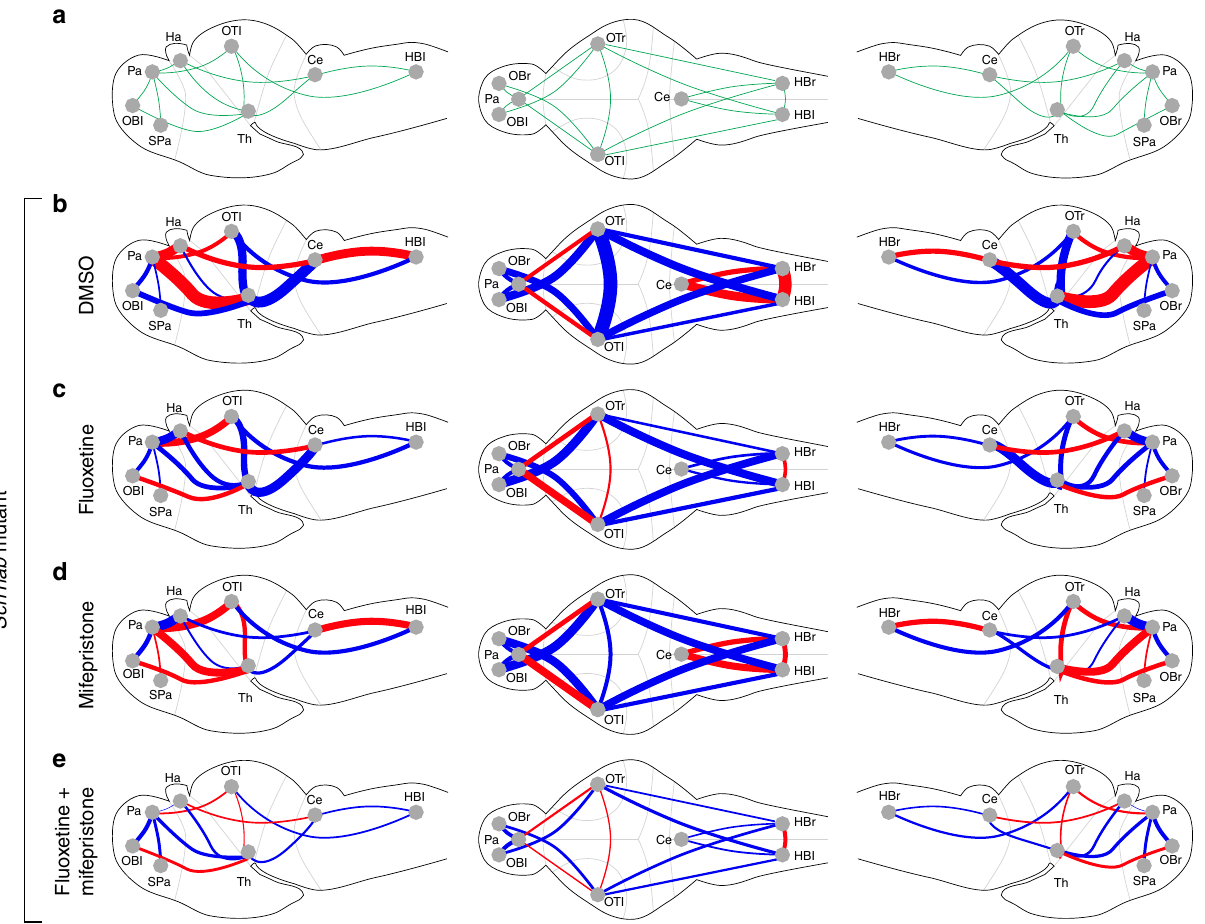
Fig. 4 Network-engineered polytherapy restores resting state brain connectivity in mutants. a Diagram depicting brain areas with statistically signi fi cant absolute correlation values (unpaired two-tailed Student's t -test; p < 0.05 considered signi fi cant; normality of datasets was tested using the Jarque – Bera normality test) in wild-type larvae at 5 dpf ( n = 10). Only these connections are shown in b – e . b – e Diagrams illustrating alterations in functional brain connectivity in scn1lab mutant larvae with respect to wild-type sibling controls under the following conditions: b untreated mutants (DMSO), c mutants treated with fl uoxetine alone at the 100% dose, d mutants treated with mifepristone alone at the 100% dose, and e mutants treated simultaneously with fl uoxetine and mifepristone using one of the optimal polytherapy dose regimens (both drugs at 30%). For all diagrams, brains are shown from the left side (left), from the dorsal side (center), and from the right side (right). Connections which increase or decrease with respect to wild-type larvae are indicated with blue or red lines, respectively. The thickness of the lines in b – e indicates the magnitude of deviation from normal wild-type connectivity. Functional connectivity for each pair of brain areas is determined at 4 + h post exposure by calculating the average absolute correlation between active supervoxels within each area during the pre-stimulus states. For each compound, the highest dose (100%) corresponds to the concentration used in the initial light- sheet-based screen (see Supplementary Table 1). Ten larvae were analyzed per condition. Ce, cerebellum; HBl, hindbrain left; HBr, hindbrain right; OBl, olfactory bulb left; OBr, olfactory bulb right; OTl, optical tectum, left; OTr, optical tectum, right; Pa, pallium; SPa, sub-pallium; Ha, Ha, habenula; Th, thalamus (For ease of illustration, the areal labels/borders are not always shown on anatomically correct